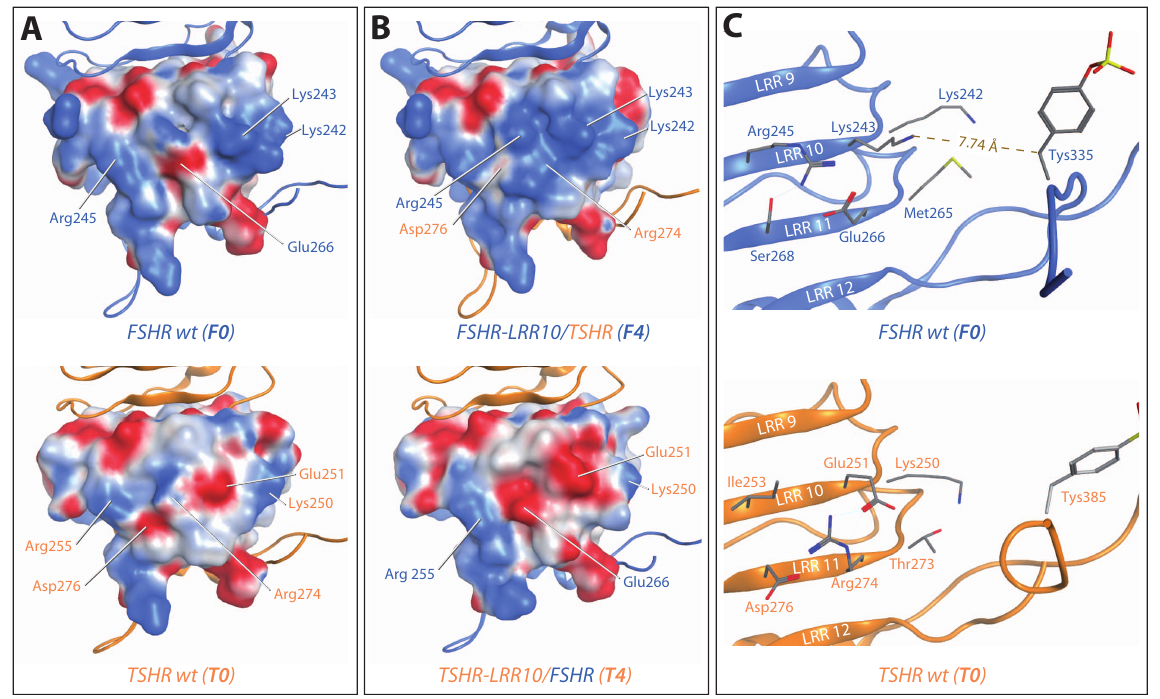
Figure 3. Charge distribution at the C-terminal part of the GPHR LRR domain. A: Marked differences in surface charges exist at the C- terminal part (LRR 10–12) of the LRR domain between the FSHR and the TSHR. While positive charges dominate this area in the FSHR, uncharged and negatively charged patches prevail in the TSHR. B: An accumulation of positive charges can be observed in construct F4 (K242, K243 and R245 from LRR10 of the FSHR and R274 from LRR11 of the TSHR) while the negative charge of D276 from LRR11 of the TSHR is hardly exposed to the protein surface. In the reversed construct T4 prominent negative charges are present at the surface of this area (E251 from LRR10 of the TSHR and E266 from LRR11 of the FSHR). C: side chains of the surface exposed residues located at the beta-sheets of LRR 10 and 11 and position of the sulfated tyrosine in the FSHR (top) and the TSHR (bottom). The distance from the terminal Nitrogen of K243 to the beta carbon of the sulfotyrosine measures 7.74 A˚ in the crystal structure of the FSHR ectodomain (14).